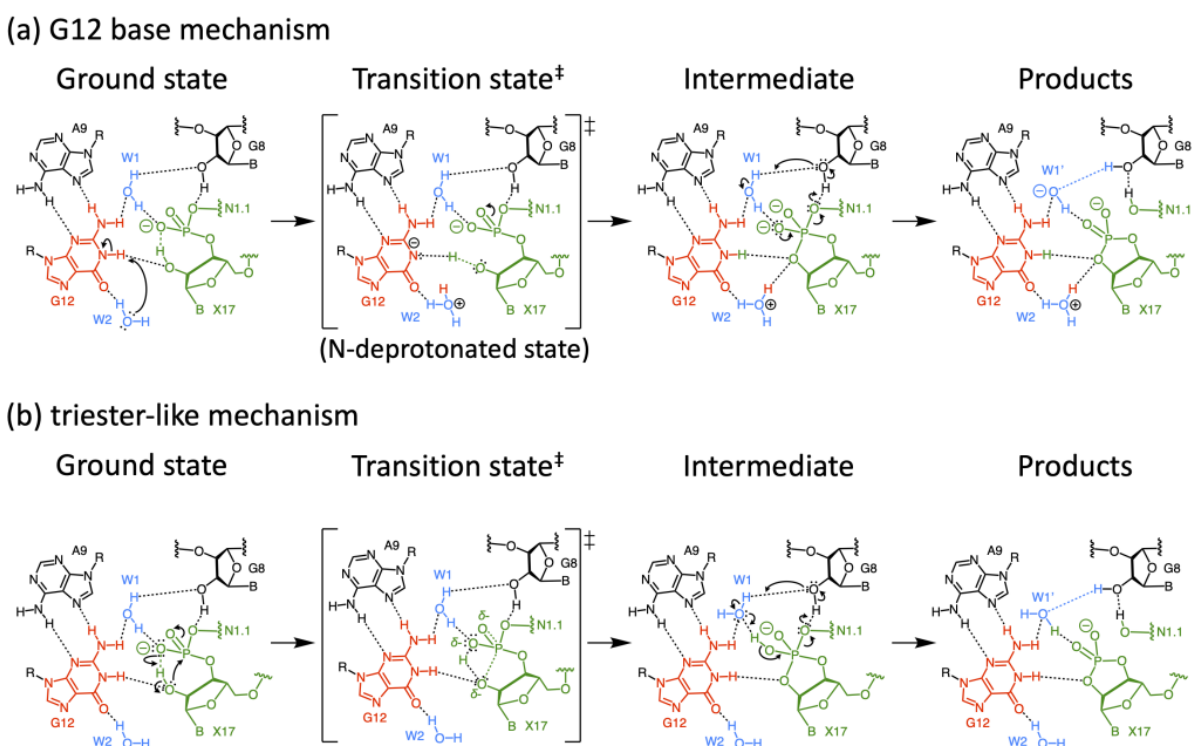
Figure 8. Schematic representation of possible reaction pathways based on the crystal structure (PDB ID: 2OEU [21]). ( a ) Possible reaction pathway of the G12 base mechanism. ( b ) Possible reaction pathway of the triester-like mechanism. In all panels, the positions of hydrogen atoms are estimated from the crystal structure, assuming typical p K a values for the respective sites [43,44,49]. Crystallo- graphically observed water molecules, which may participate in the catalysis, are drawn. Even after the proton transfer, the colors of protons are retained in their original residue’s/molecule’s colors.